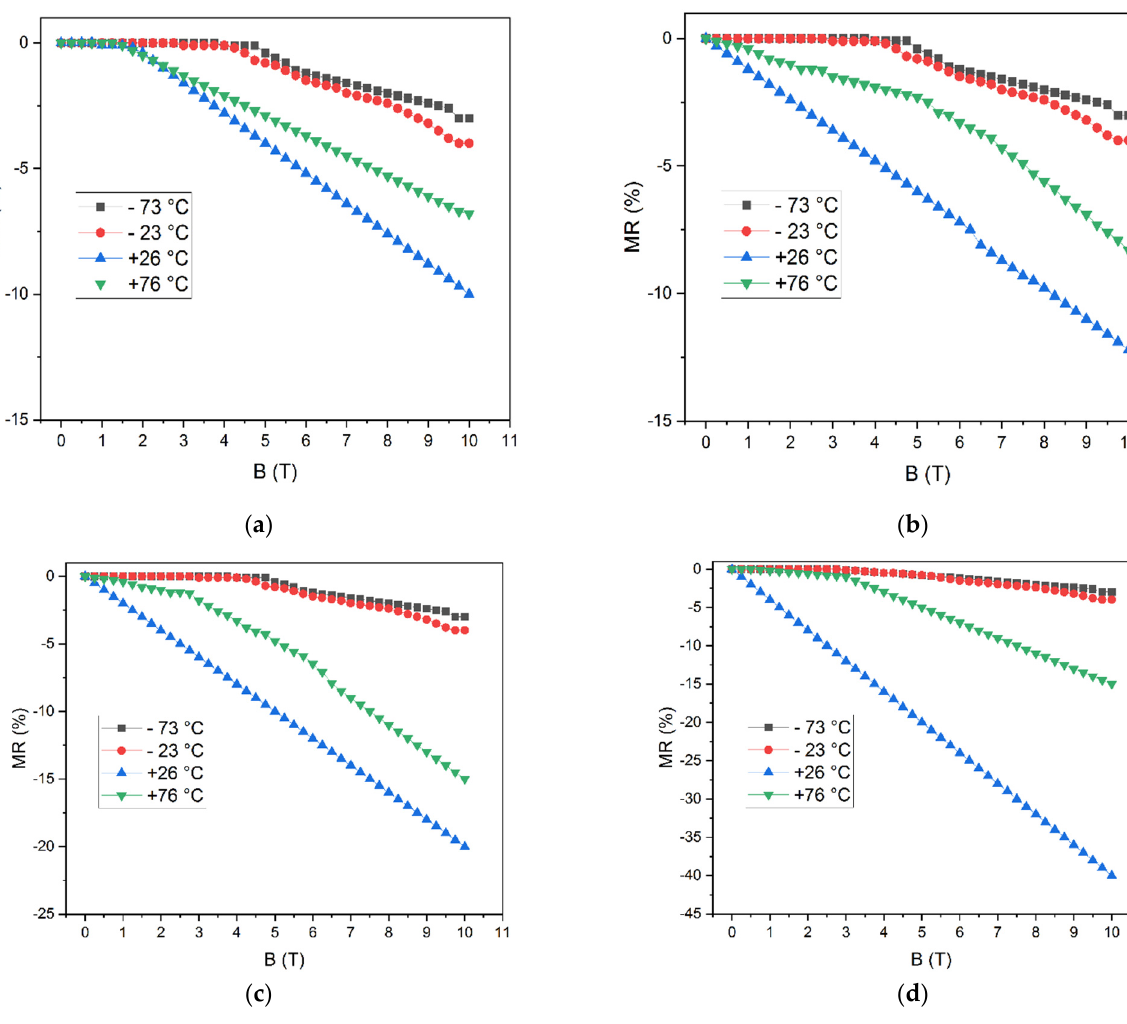
Figure 7. Isothermal magnetoresistance for Ni 50 − x Fe x Mn 30 Sn 20 − y In y , where 1 ≤ x ≤ 4; 2 ≤ y ≤ 8 alloy and ( a ) x =1, ( b ) x = 2, ( c ) x = 3, and ( d ) x = 4. All samples indicate a linear relationship between the negative MR and B with a temperature-dependent slope Δ (MR)/B. At low temperatures, when the sample is in the martensite phase, the value of (MR)/B is minimal due to its paramagnetic (SPM) state. For instance, in the alloy with x = 4 and y = 8 at a temperature of T = − 173 °C, when the sample is in the PM state, the (MR)/B is 1.12%/T. This value is almost the same in the PM regions, i.e., at T = − 73 and − 23 °C. At the SPM to PM transition temperature of − 23 °C, the value rises significantly by 26%. The (MR)/B is still more than 2.4%/T at T = 46.85 °C and 2.64%/T at T = 66.85 °C in the magnetically and structurally unstable martensite transition area. A significant shift in the magnetic and electronic structures associated with the martensite transition might present itself in the form of a big (MR)/B value or a large negative MR. The MR values shown versus the temperature show similar tendencies for the other alloy compositions with tiny crystallites. When the alloy (x = 3 and y = 6) is heated to the austenite phase of 26 °C, the (MR)/B ratio is 16% less than that seen around the martensite transition point of 19 °C. This is clearly due to the spin ordering present in the austenite phase. The presence of a rather substantial (MR)/B value at both low and high magnetic fields and temperatures near to the TA point indicates that the current Heusler alloys composed of tiny crystallites have considerable promise for both low and high magnetic field MR applications.